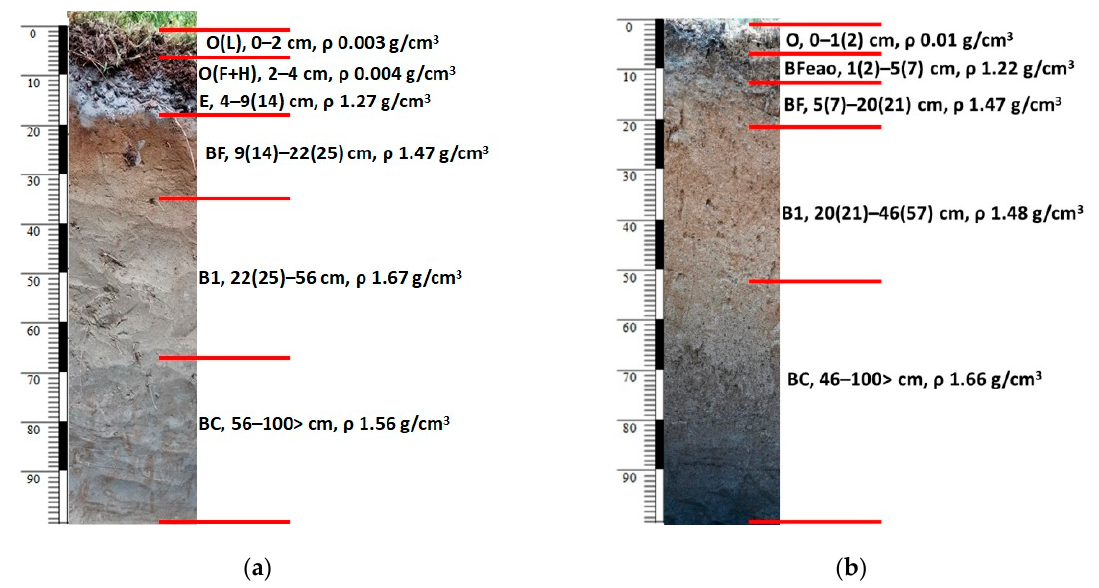
Figure 2. ( a ) Albic Podzol Arenic soil of SP 2, Blueberry pine forest, 80 years. ( b ) Entic Podzol soil of SP 8, Lichen pine forest, 70–80 years. The rulers are 90 cm.